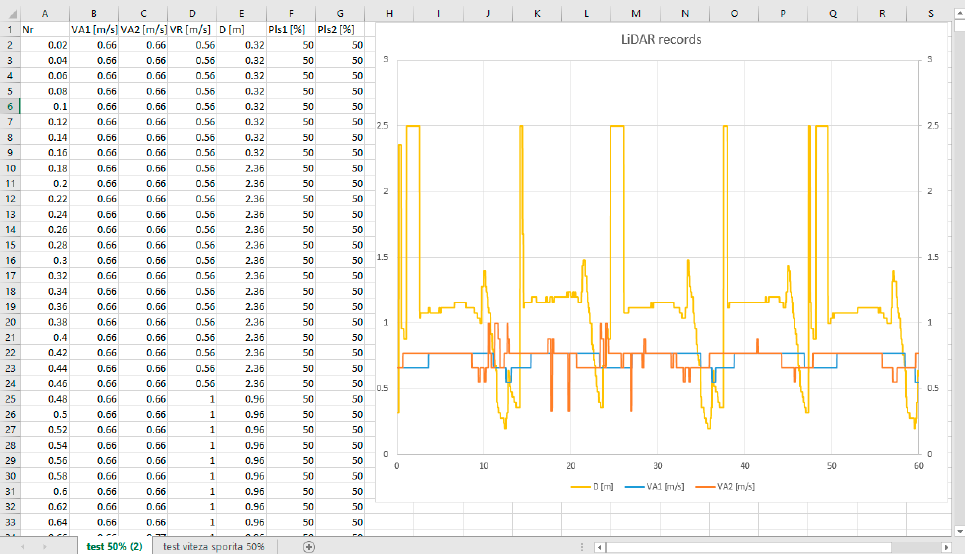
Figure 14. Data saved in csv file and plotted in Excel.